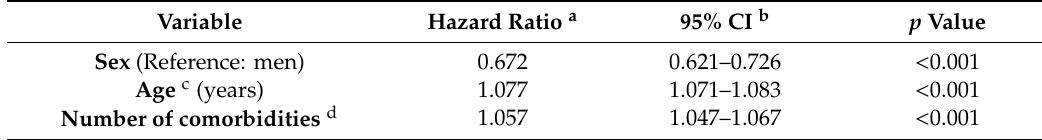
Table 5. Cox regression survival analysis to assess the risk of 1-year mortality in men and women with heart failure based on sex, age, and number of